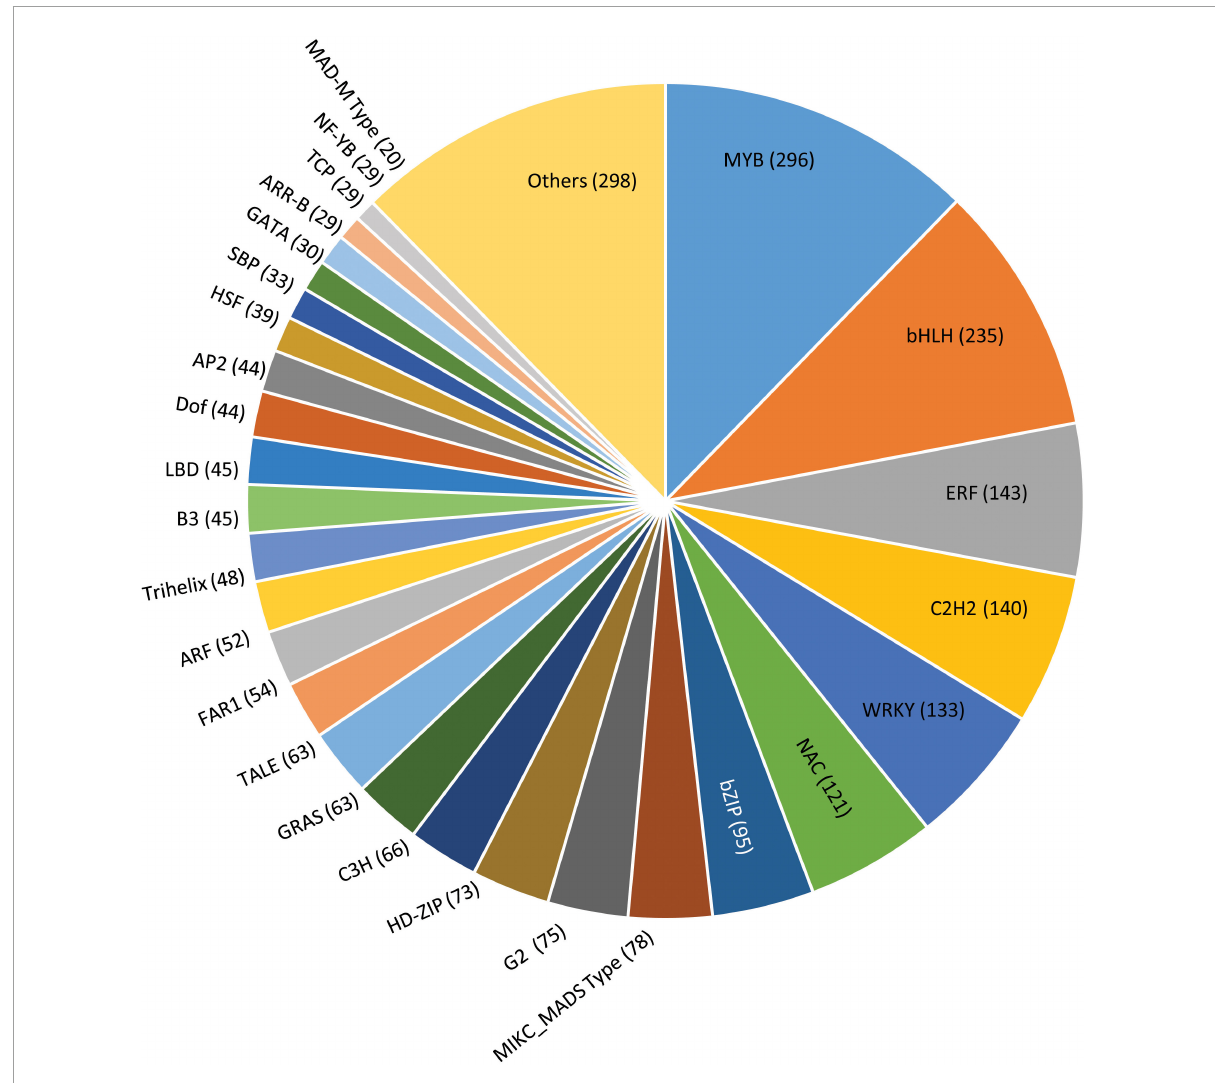
FIGURE7 A pie chart showing distribution of scaffolds into various transcription factor families in pongamia. Values in a parenthesis represent the number of scaffolds for each